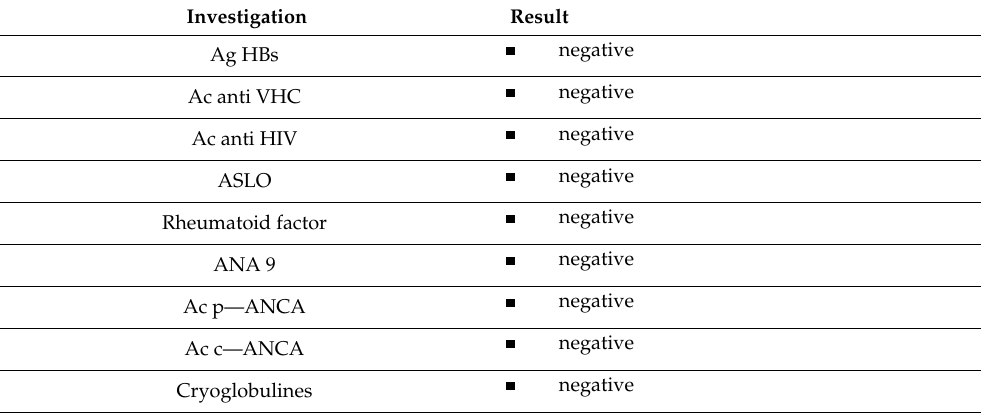
Table 2. Serological